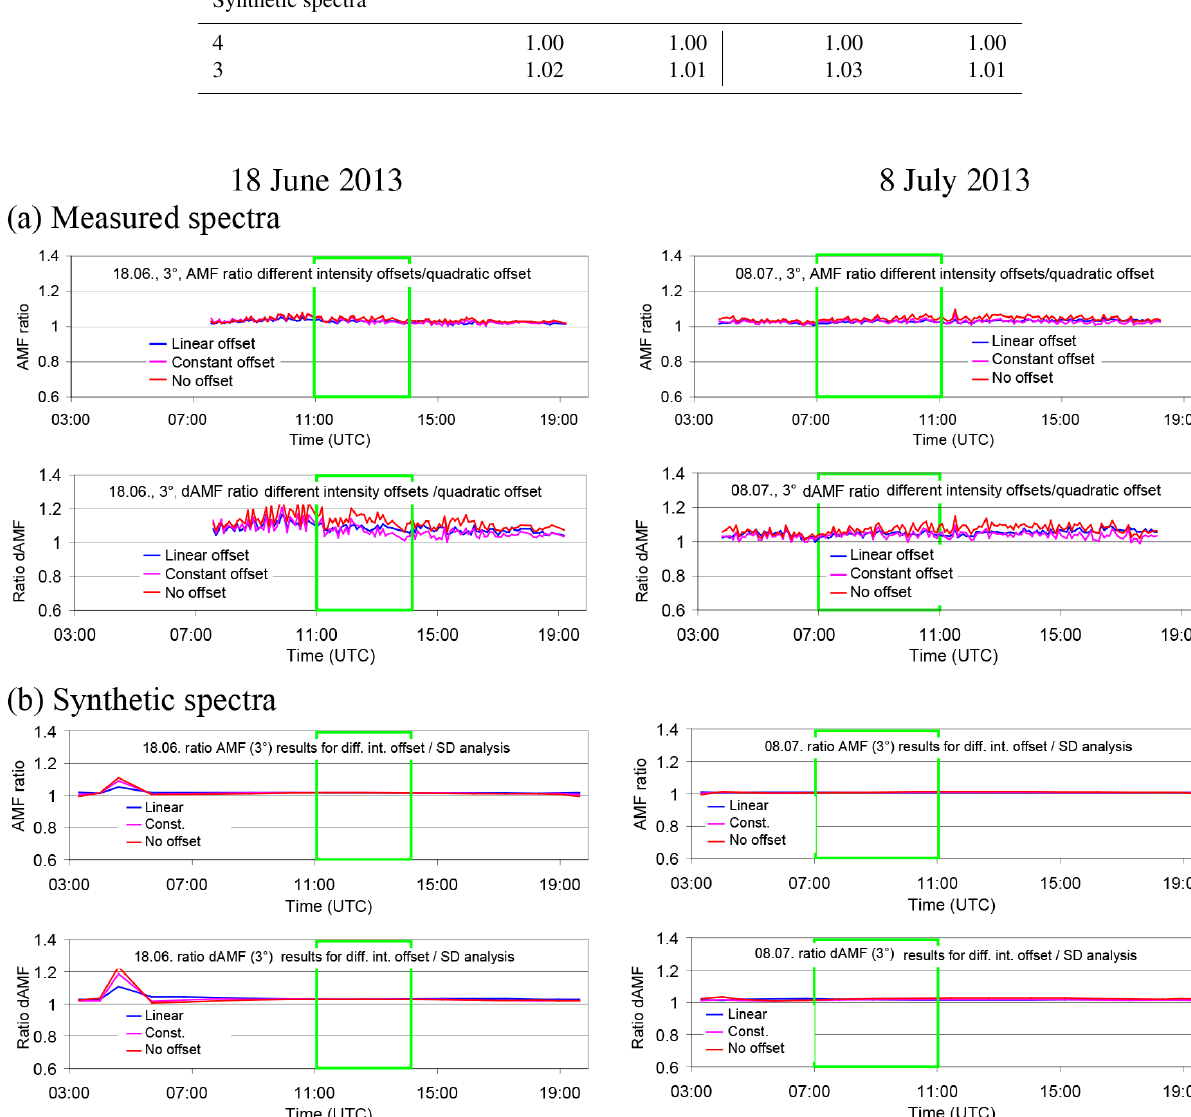
Figure A17. Ratios of the O 4 (d)AMFs derived for different intensity offsets vs. those for the standard analysis (intensity offset of degree 2) for both selected days ( a : results for spectra measured by the MPIC instrument; b : results for synthetic spectra when taking into account the temperature dependence of the O 4 cross